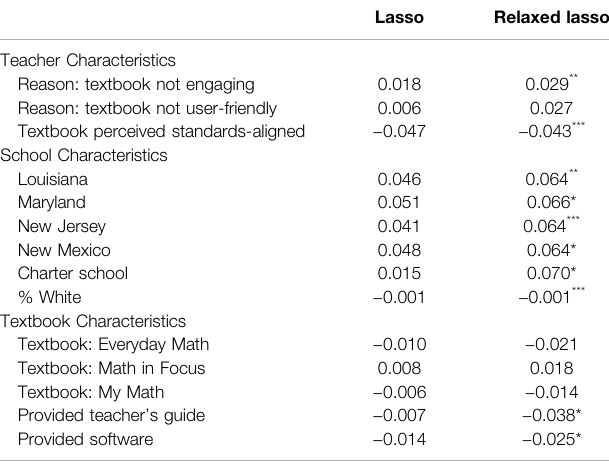
TABLE 6 | Incidence of supplementation. Proportion of lessons in which teachers report using teacher-created (not “ expert-created ” ) materials. Lasso Relaxed